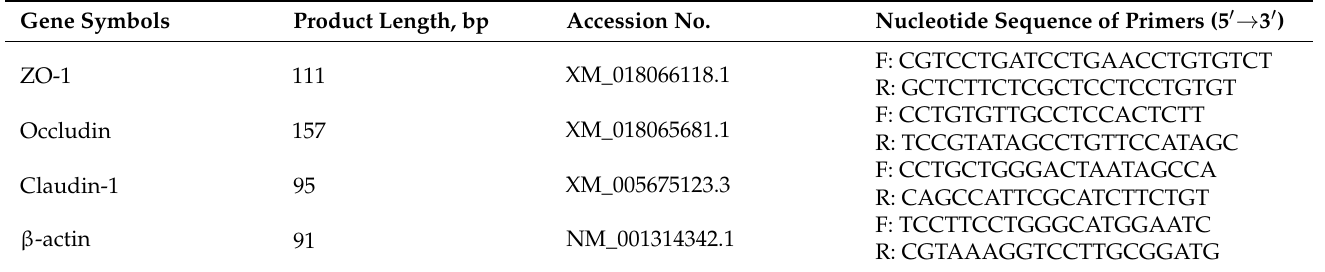
Table 2. Nucleotide sequences of primers used to measure targeted